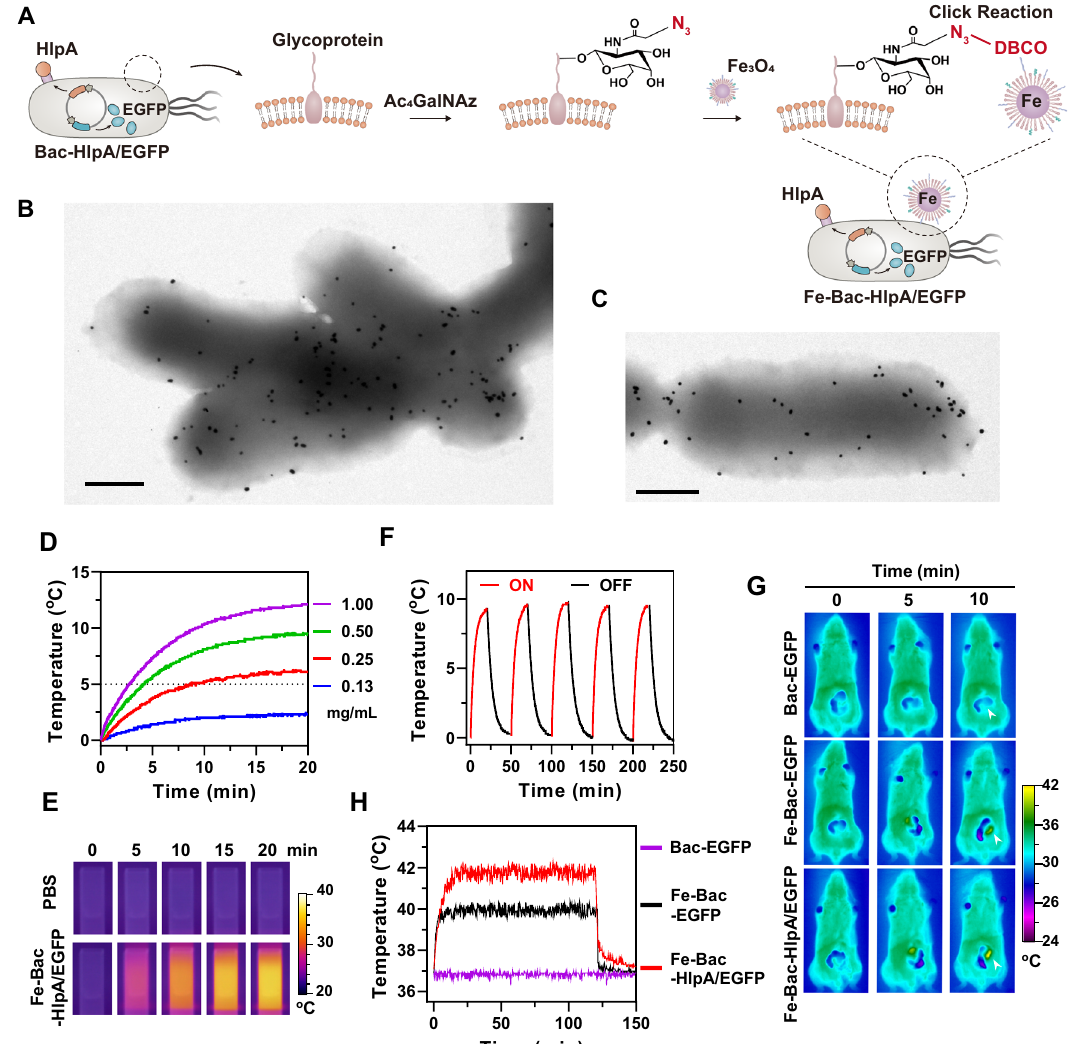
Fig. 2 | Assembly of the signal decoding module. A Diagram of site-speci fi c coupling of DBCO-Fe 3 O 4 onto the tumor-homing bacteria. The reactive functional groups (-N 3 ) were introduced onto the bacterial surface via metabolic oligo- saccharide engineering, through culturing bacteria with a non-natural form of galactosamine (Ac 4 GalNAc). DBCO-Fe 3 O 4 were conjugated onto the N 3 -modi fi ed bacteria through the click chemistry reaction between DBCO and -N 3 moieties. B , C TEMimagesofbacteriamodi fi edwithFe 3 O 4 NPs.Site-speci fi c( B )andnon-site- speci fi c( C )labelingmethodswereemployedtoconjugateFe 3 O 4 NPsontobacteria. Scale bar, 0.5 μ m. D Temperature elevation of aqueous solutions of Fe-Bac-HlpA/ EGFP at different Fe 3 O 4 concentrations (0.13 – 1.00mg/mL) during treatment with AMF at a fi xed frequency of 310kHz and intensity of 14.6kA/m. E Infrared imaging of Fe-Bac-HlpA/EGFP solutions (1.00mg/mL Fe 3 O 4 ) upon AMF treatment (310kHz and14.6kA/m)fortheindicatedtimeintervals(0 – 20min). F Temperaturechanges